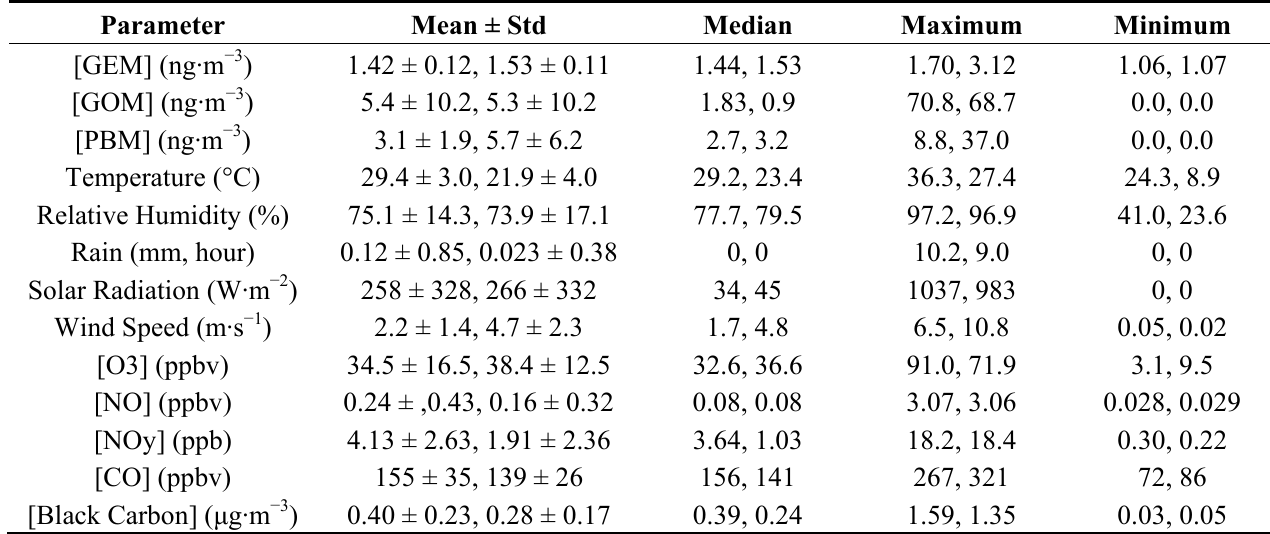
Table 1. Statistical summary of hourly measurements during the two intensives in summer 2010 (the first number in each cell) and spring 2011 (the second number in each cell).